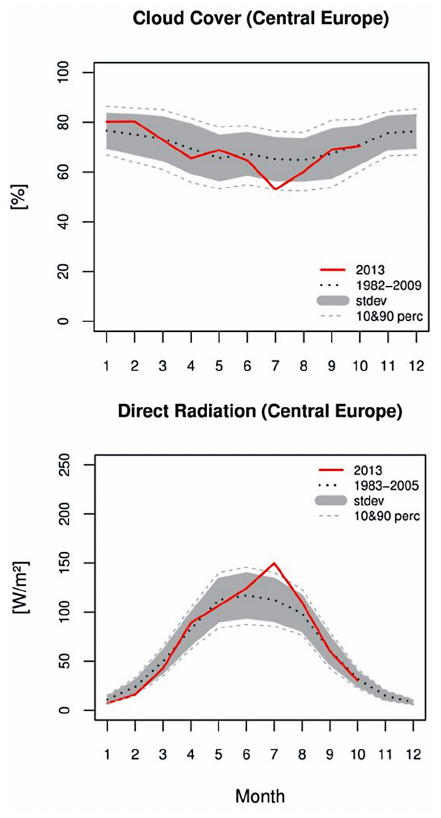
Figure 4. Annual course of monthly means of cloud cover and di- rect radiation for the central European subregion. Long-term aver- ages, standard deviations and extreme percentiles are provided as a reference. The products for October 2013 are shown (provided in November 2013).